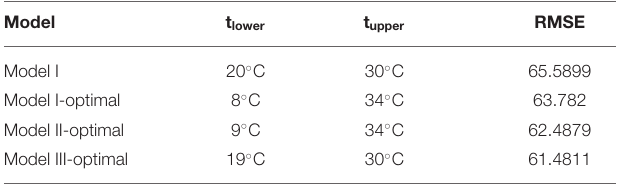
TABLE 1 | The optimal values of t lower , t upper and the RMSE for Model I, Model II, and Model